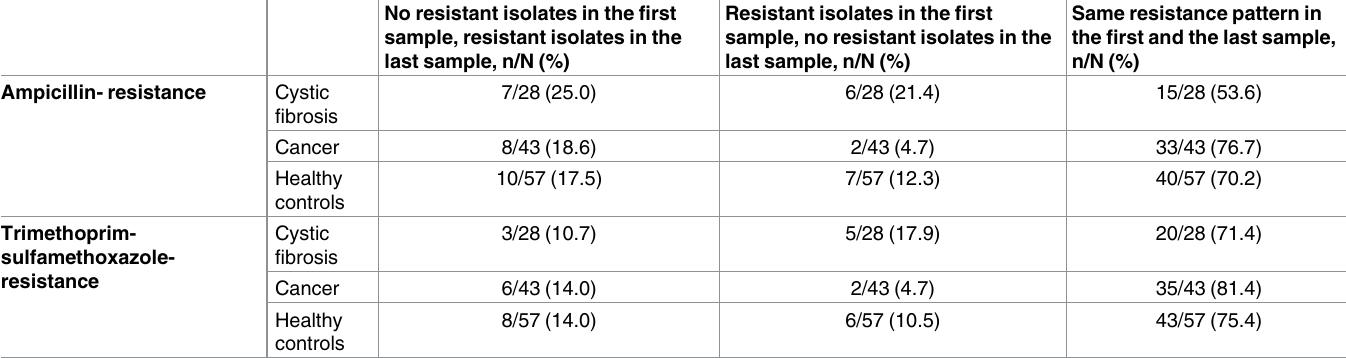
Table 5. Occurrenceof shift in ampicillin and trimethoprim-sulfamethoxazole susceptibility in faecal Escherichia coli between the first and the last faecal sample collected from children with cystic fibrosis, cancer and healthy